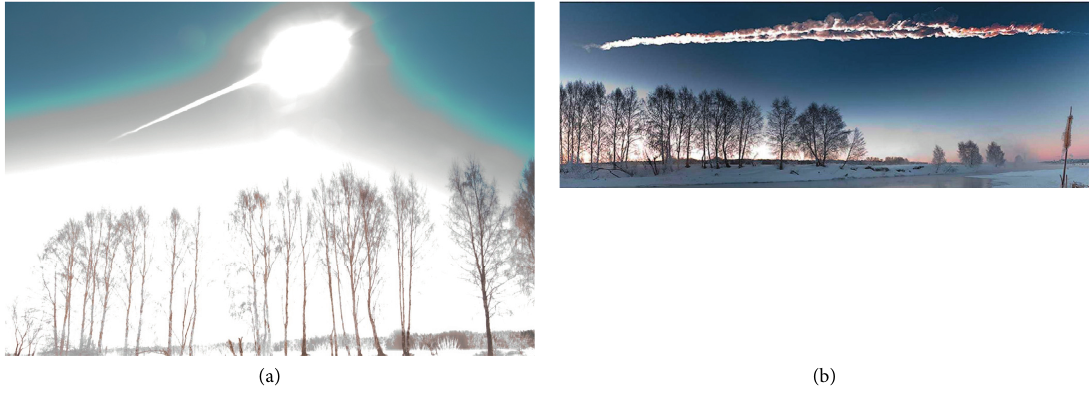
Figure 6: A casual photograph of the Chelyabinsk bolide taken by Marat Ahmetvaleev. (a) The abrupt fragmentation at a height of 23km is clearly distinguishable by the main flare. (b) Pictures of the dust trail by the same photographer reveal multiple paths produced by the fragments. Both pictures are courtesy of the author.